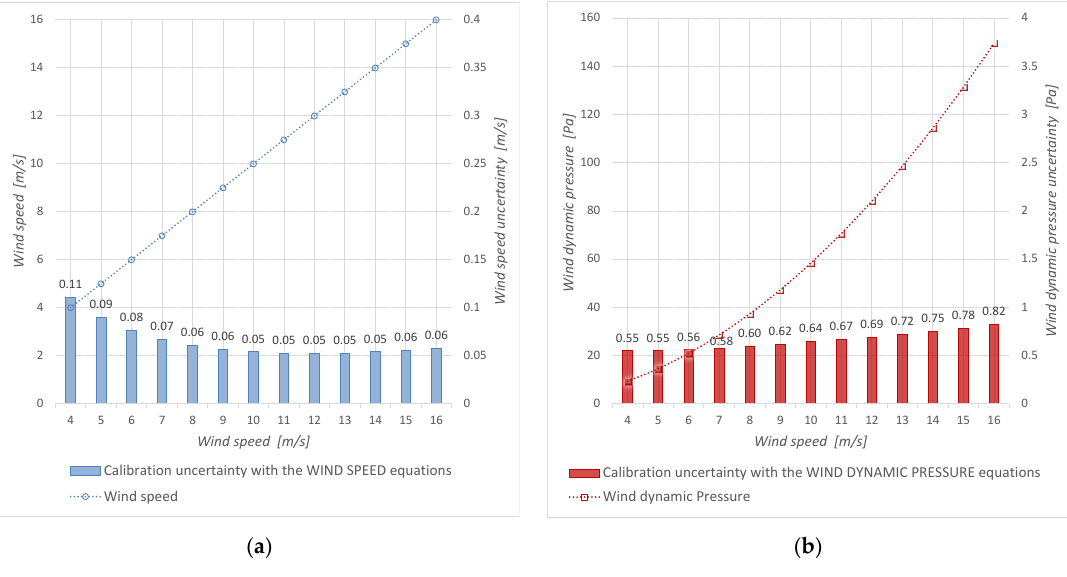
Sensors 2019 , 19 , x